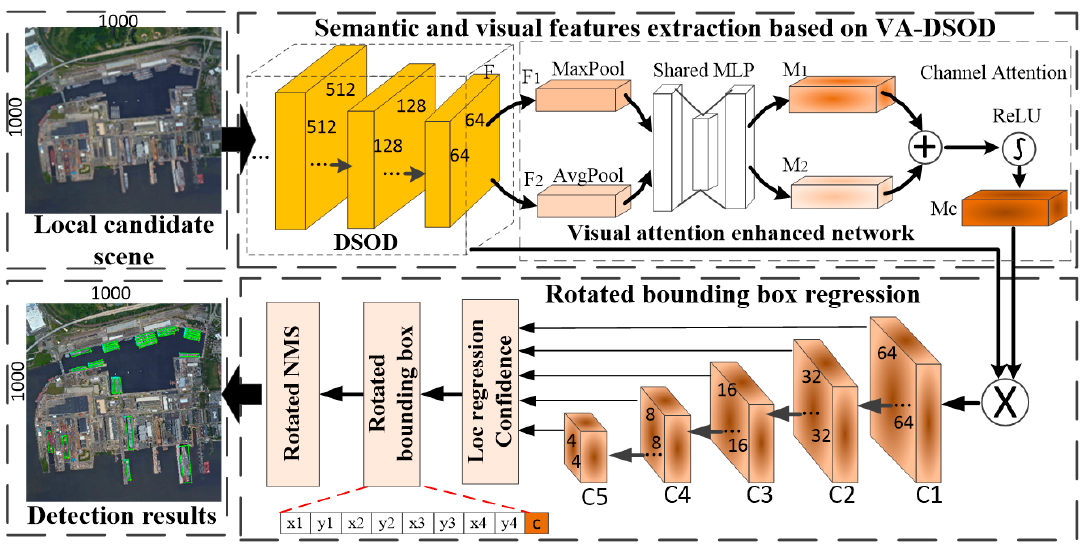
Figure 3. The flow chart of ship detection based on VA-DSOD.